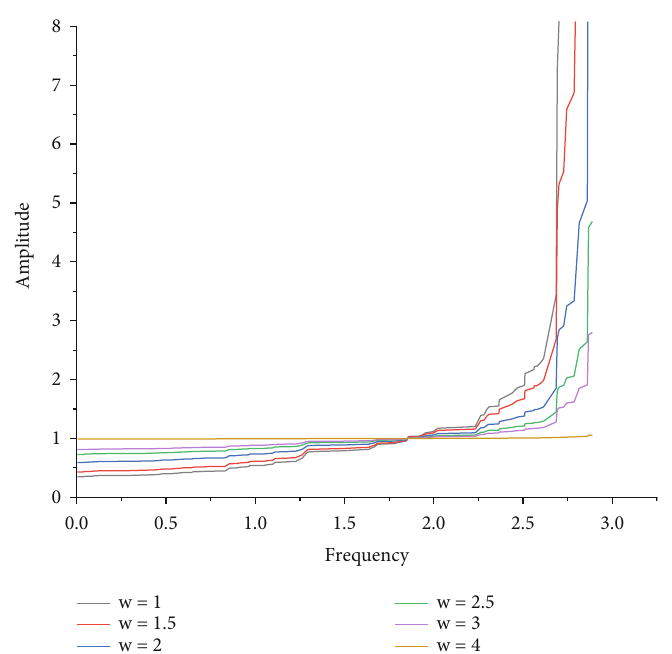
Figure 1: Amplitude-frequency characteristic curve of fractional-order di ff